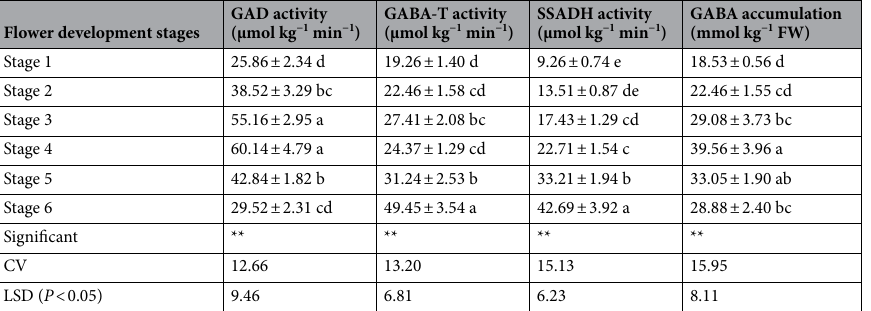
Flower development